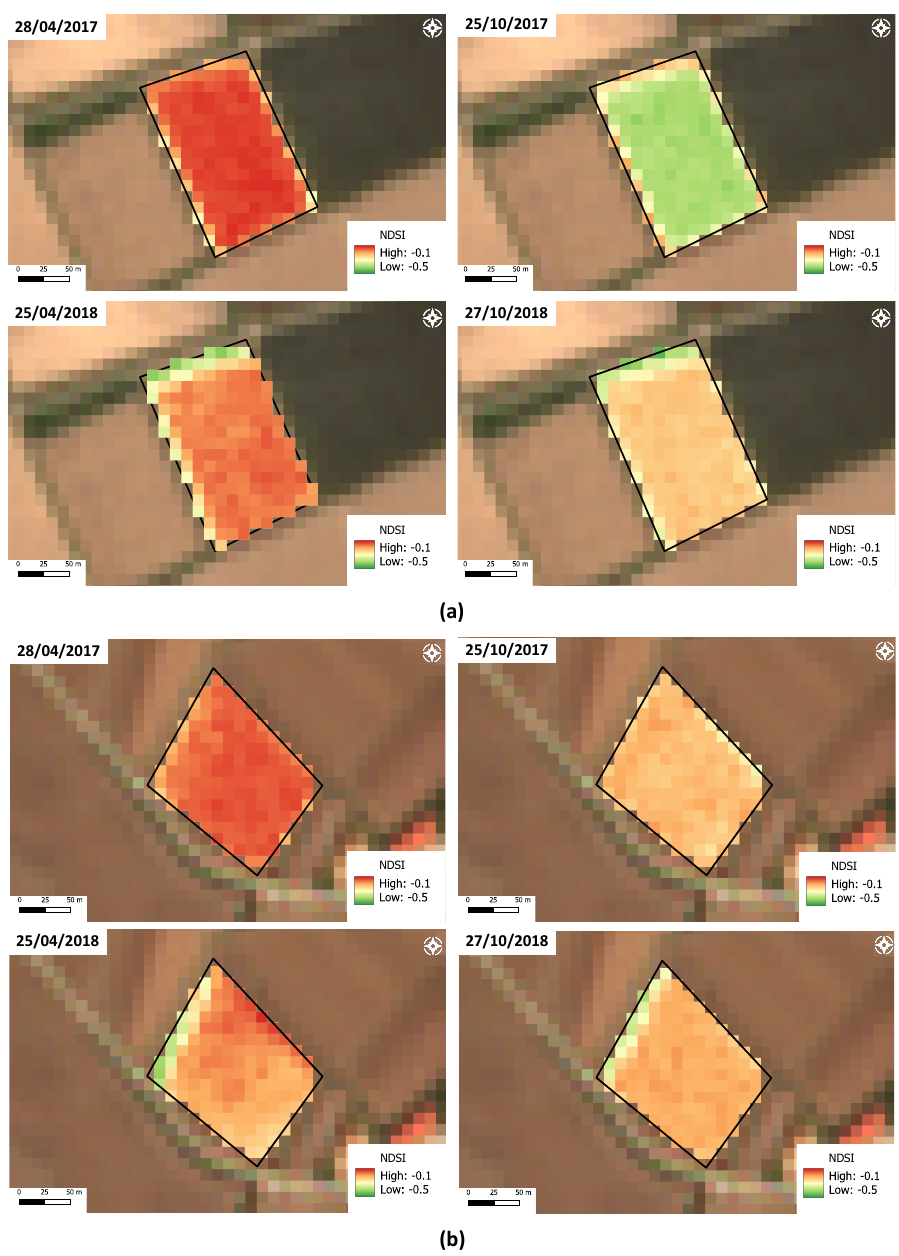
Figure 4. Spatial distribution of NDSI in the selected field plots: ( a ) Quinta do Canal and ( b ) Pranto. The samples are from Spring and Autumn of 2017 (top panels) and 2018 (bottom panels), before and after the rice crop cultivation period (left and right panels, respectively).